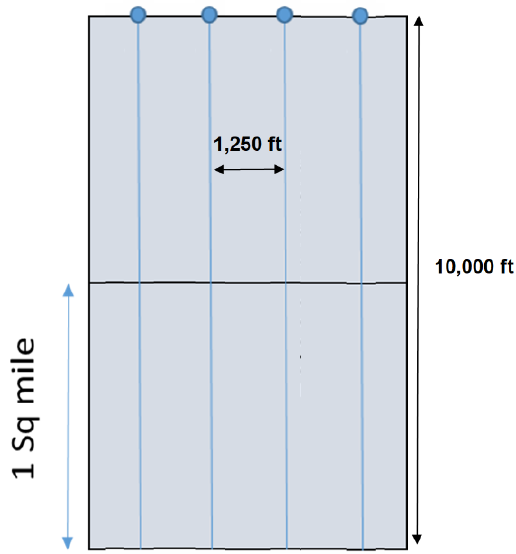
Figure 4. Four 10,000 ft single lateral producers (Wells A-D) are drilled to drain two sections at 1250- ft well